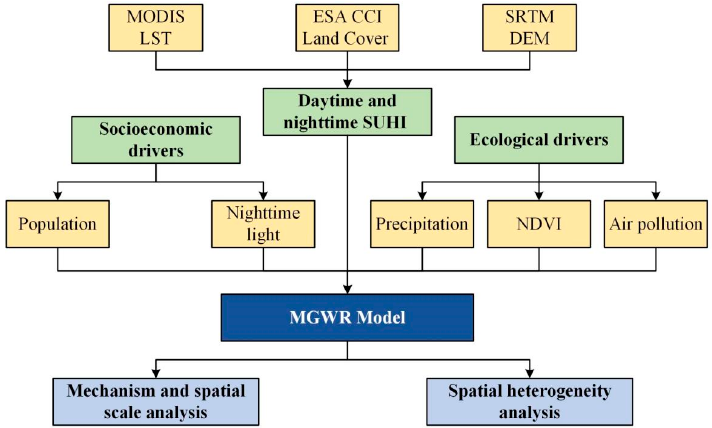
Figure 3. The overall framework of the study. Note: SUHI = surface urban heat island intensity; NDVI = normalized difference vegetation index; MODIS LST = Moderate Resolution Imaging Spectroradiometer land surface temperature; ESA CCI = European Space Agency’s Climate Change Initiative; SRTM DEM = Shuttle Radar Topography Mission Digital Elevation Model; MGWR = the population at the end of the year.